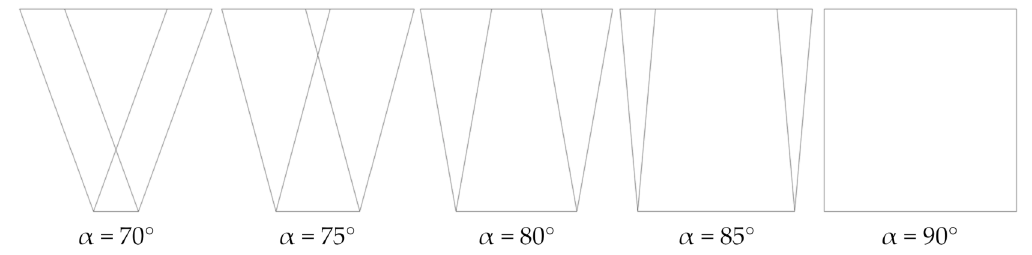
Figure 9. Geometry variations for the 4th design.